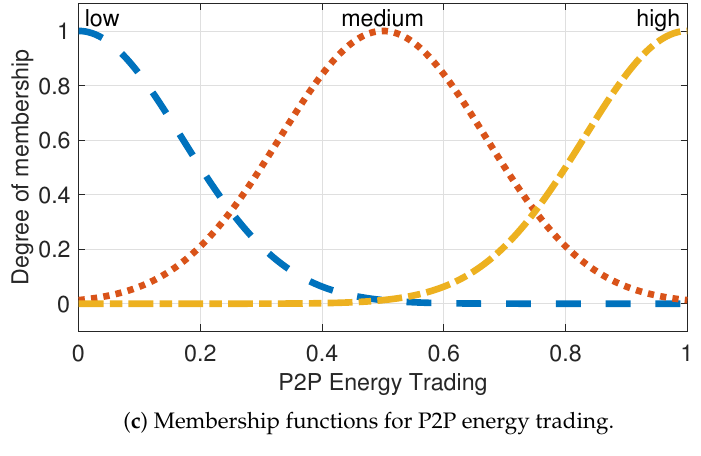
Figure 5. Output membership